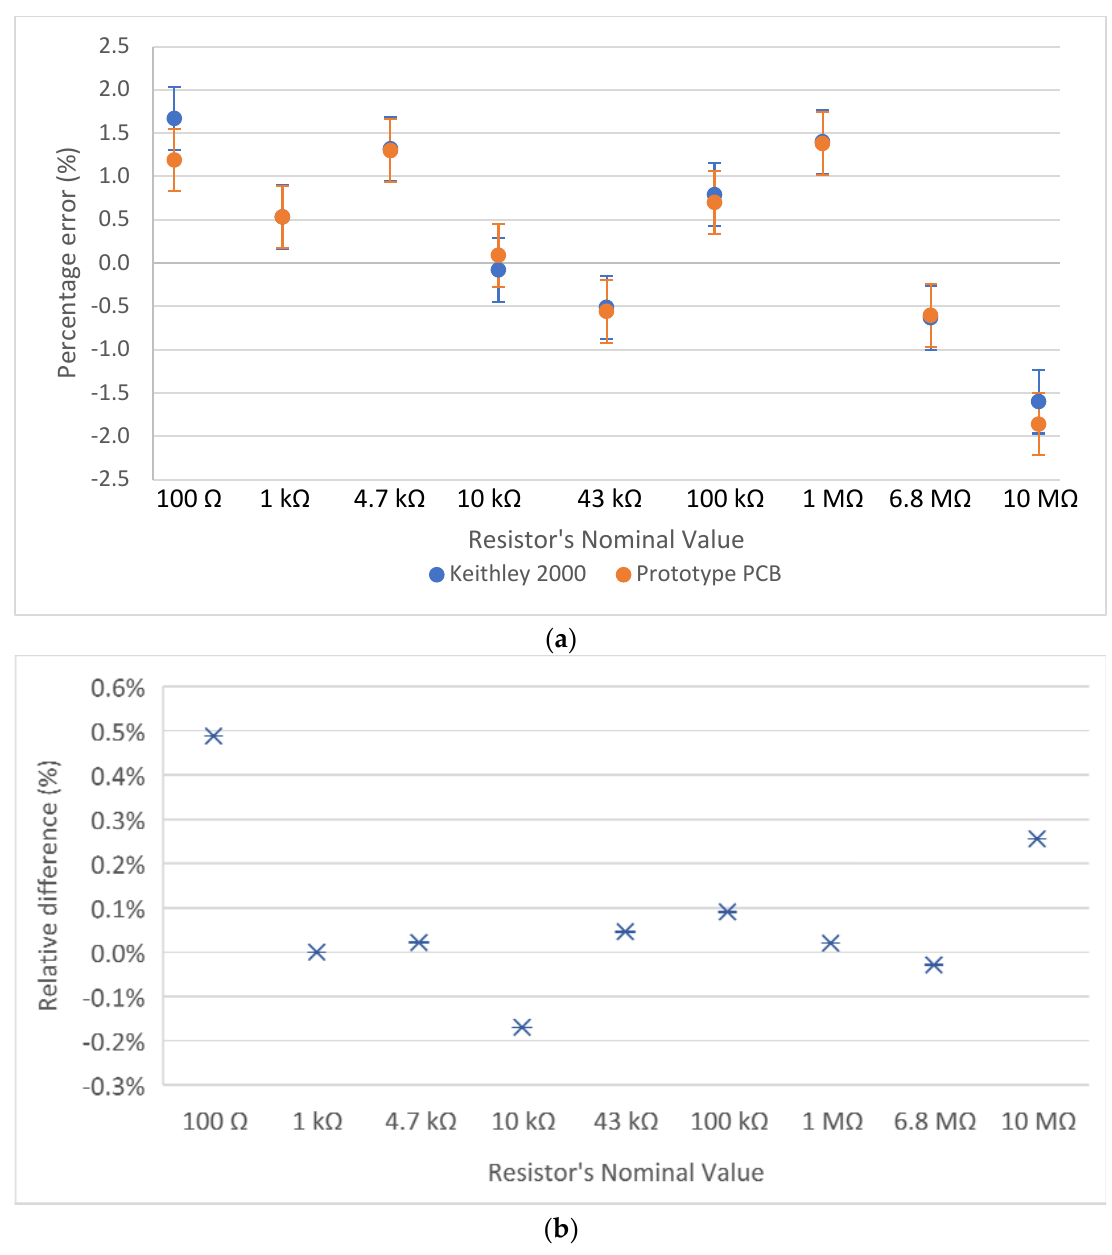
Figure 5. Resistance measurements of 9 resistors; ( a ) the absolute percentage difference between the nominal resistance value, a benchtop multimeter, and the developed circuit; ( b ) the relative difference between the developed circuit and the reference multimeter.